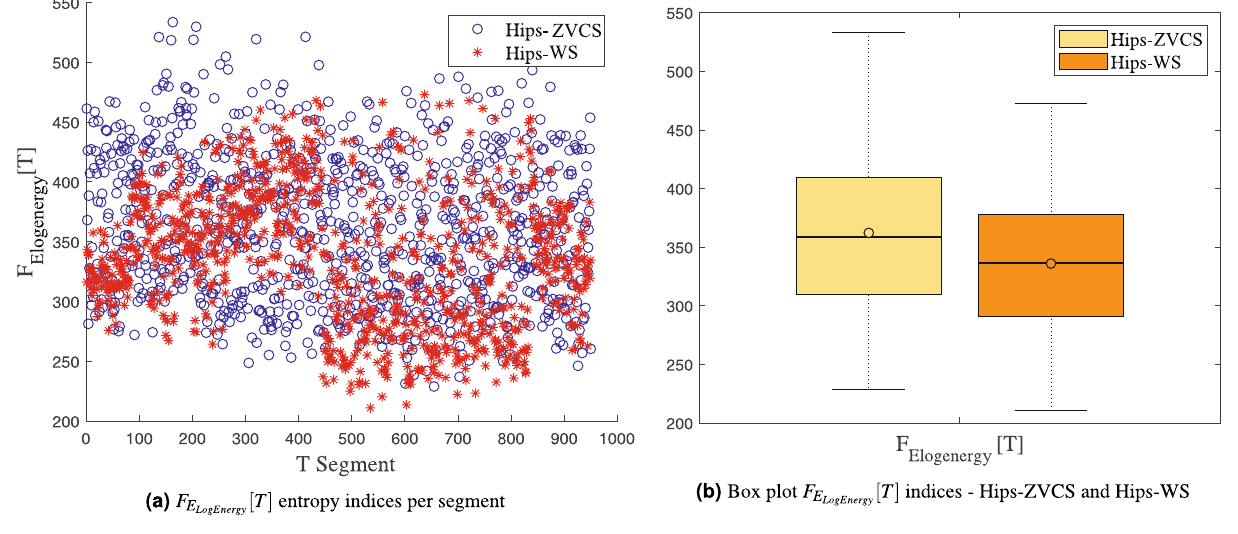
[ T ] entropy measurement indices. LogEnergy